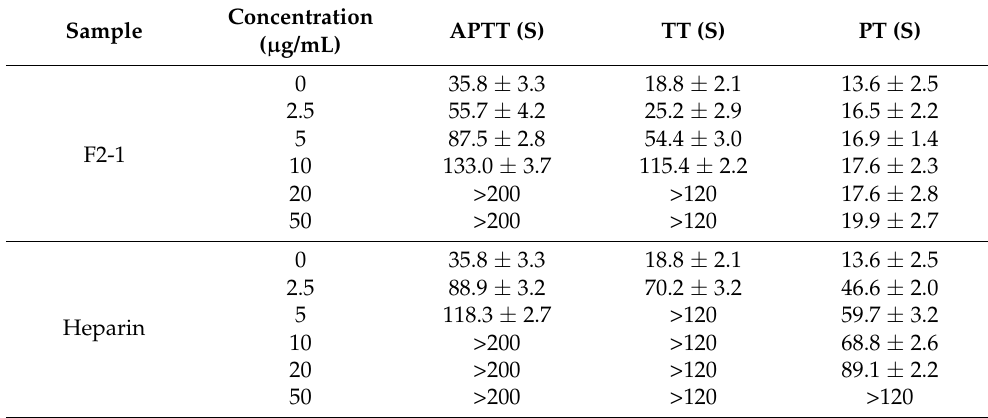
Table 3. Anticoagulant activities of the sulfated polysaccharide F2-1 by APTT, TT, and PT compared with